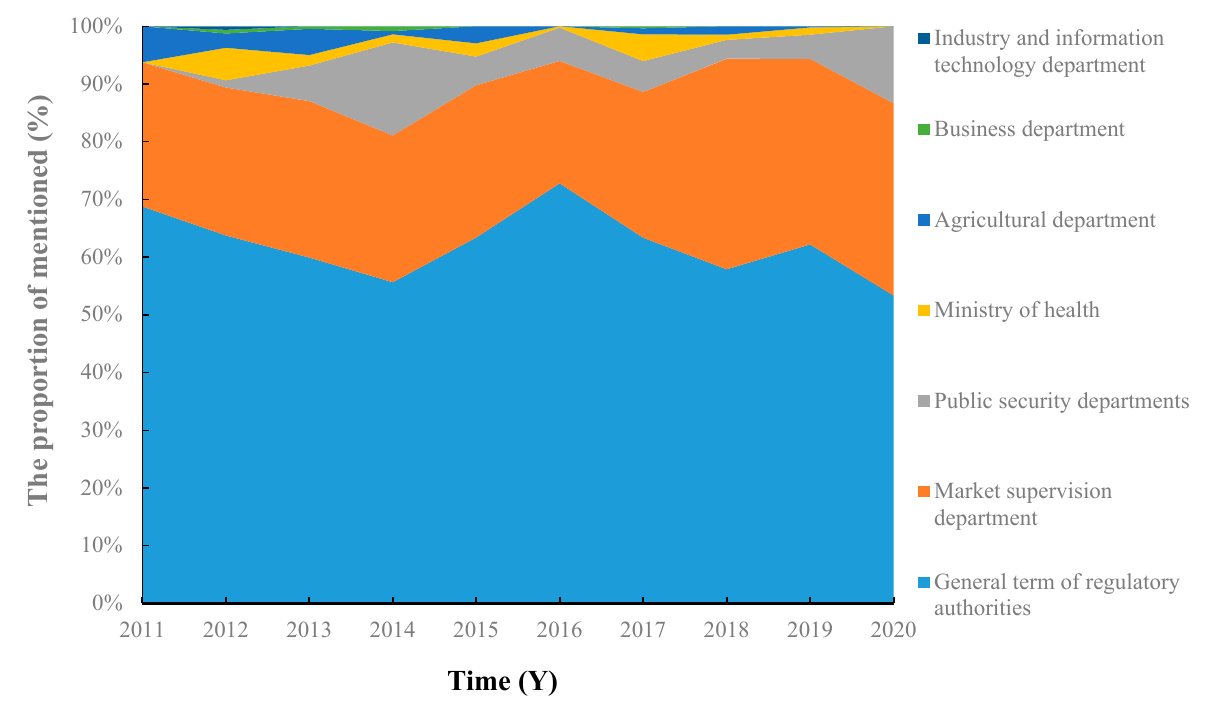
Figure 3. Trends in consumer perceptions of the regulatory authorities from 2011 to 2020.